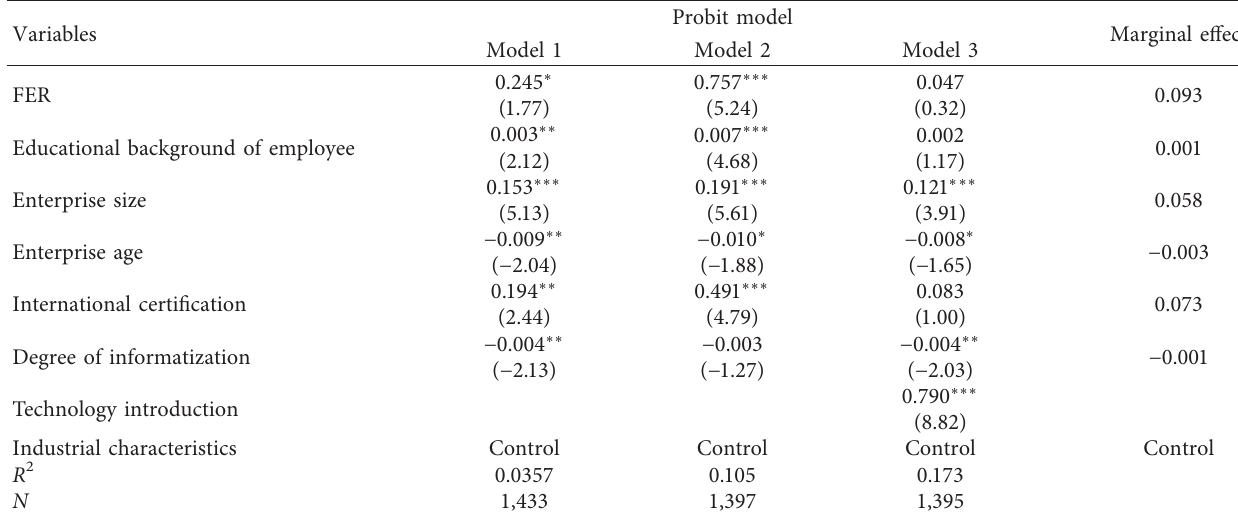
Table 4: Model regression